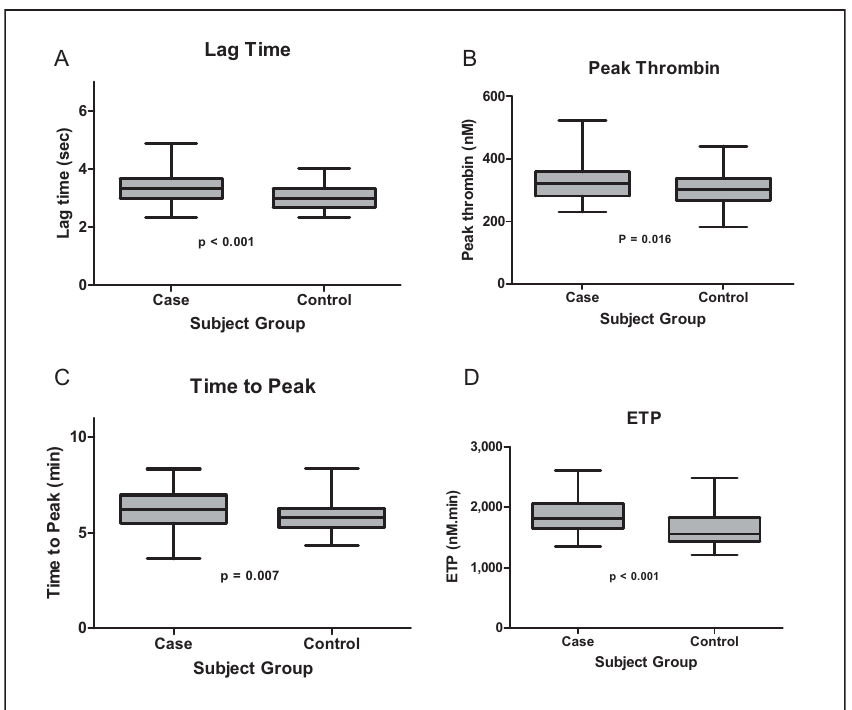
Fig. 2 Comparison of thrombin generation parameters in cases and controls. ( A ) Mean lag time in cases was signi fi cantly higher than in the control group: 3.33 (cid:5) 0.56 versus 3.0 (cid:5) 0.41, p < 0.001. ( B ) Mean peak thrombin was higher in the cases compared with the control group: 322 (cid:5) 54 versus 304 (cid:5) 55, p ¼ 0.016. ( C ) Mean time to peak was higher in cases than in the control group: 6.20 (cid:5) 0.99 versus 5.77 (cid:5) 0.81, p ¼ 0.007. ( D ) Cases had a signi fi cantly higher mean ETP compared with the control group: 1,854 (cid:5) 287 versus 1660 (cid:5) 282, p <